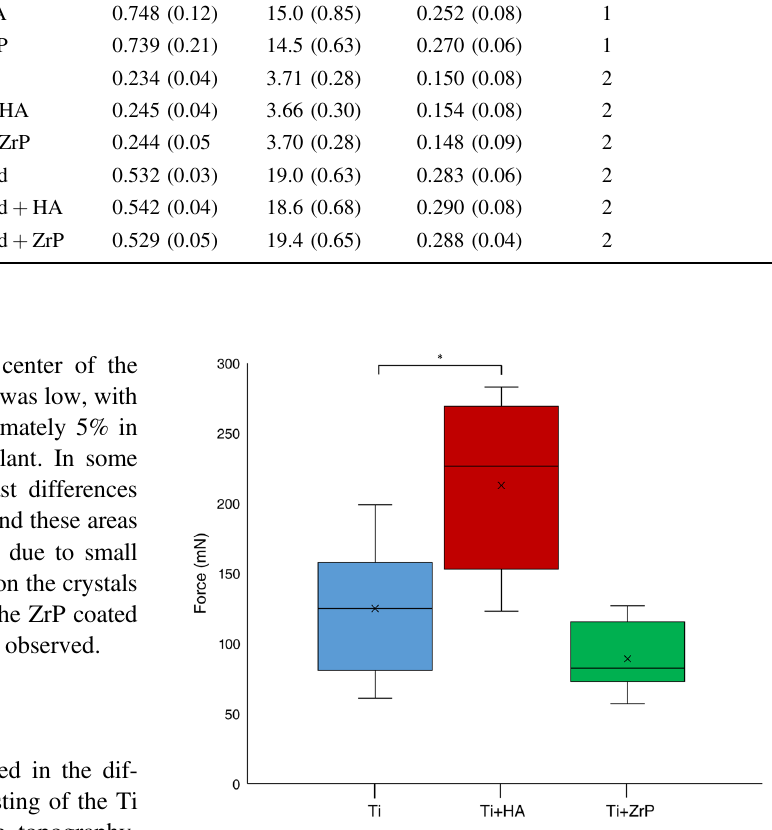
Fig. 11 Graph (box and whisker plot) of the pullout forces from Test